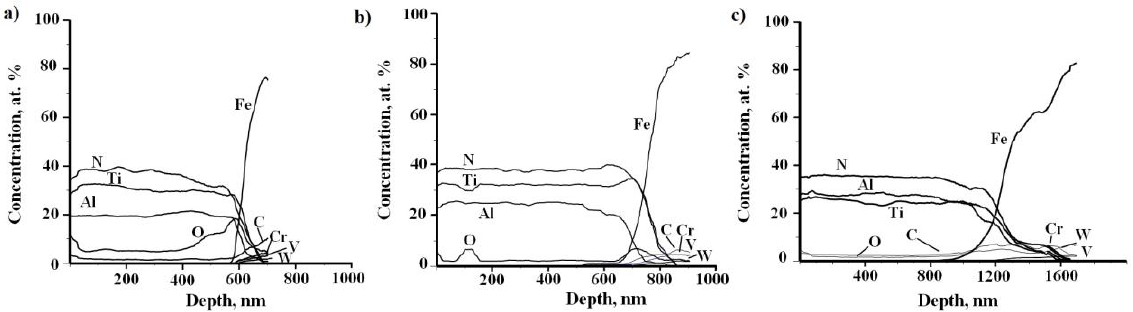
Figure 3. AES distribution profiles of elements in the samples deposited at I Al : 70 A ( a ); 80 A ( b ); 90 A ( c ).